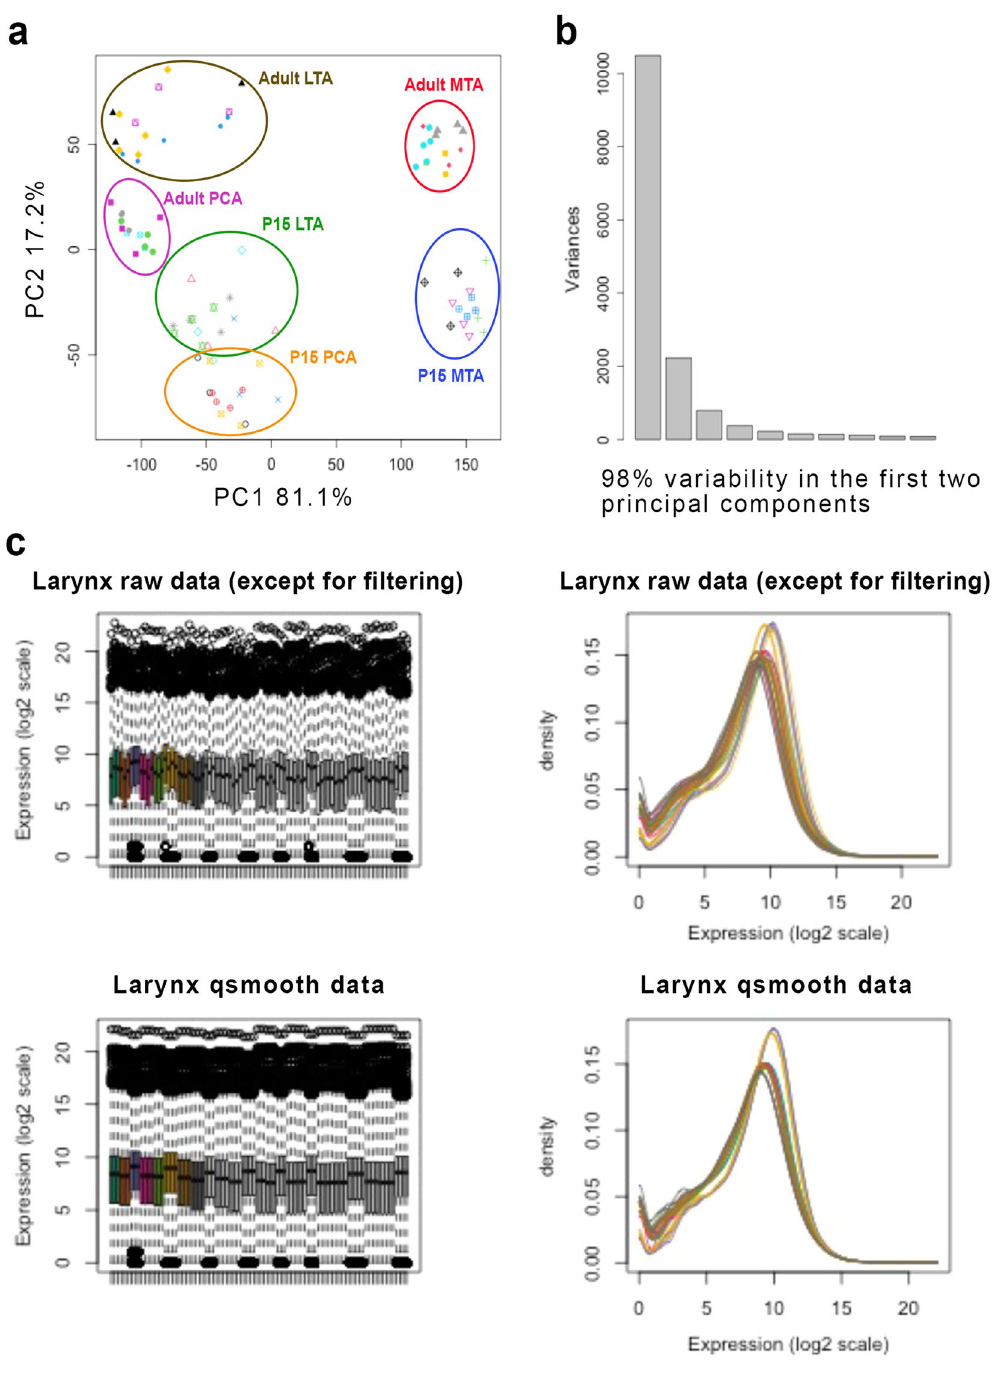
Figure 7. RNA-Seq diagnostics. The samples were sequenced using the NovaSeq 6000 platform (Illumina, Inc) ( a ) The principal component analysis shows a global summary based on the variance of the log2 concentration. ( b ) The scree plot shows the relative amount of variance in each principal component. ( c ) Samples were normalized with qsmoooth as shown in raw diagnostics